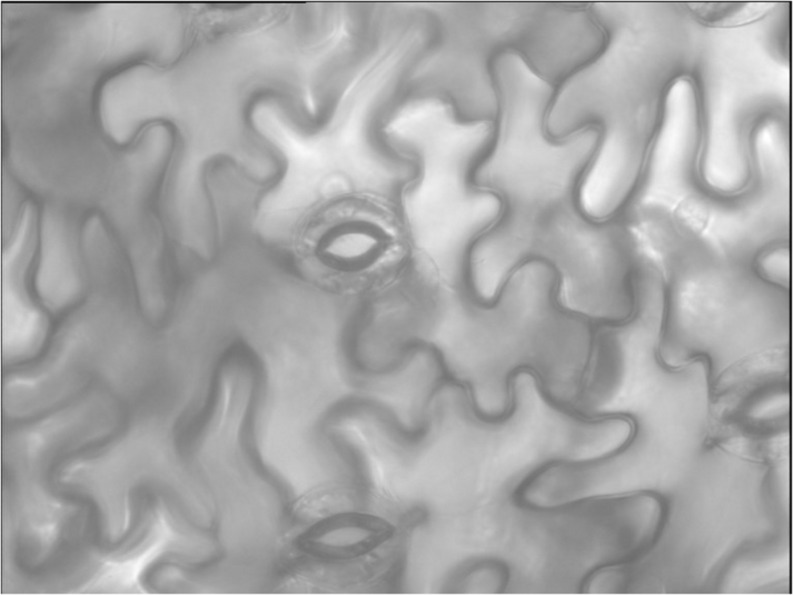
Typical stomatal pores whose areas (A) were measured. Representative example at low VPD (0.33 kPa). Micrograph dimensions 300 × 300 μm.